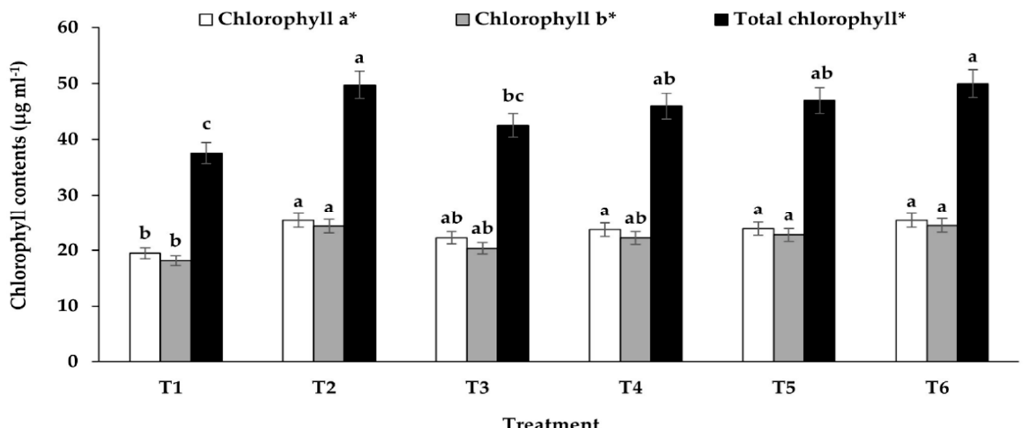
Figure 3. Chlorophyll a, b, and total chlorophyll contents in sunchoke. Data are the means of four replications. Six treatments are indicated as follows: (T1) uninoculated plants, (T2) full-dose chemical fertilizer-treated plants, (T3) half-dose chemical fertilizer-treated plants, (T4) EPF-inoculated plants, (T5) AMF-inoculated plants, and (T6) co-inoculation of EPF and AMF-treated plants. Error bars represent the standard deviations of four replicate data. Different letters above the bars indicate significant differences. * Significant difference at p ≤ 0.05. *